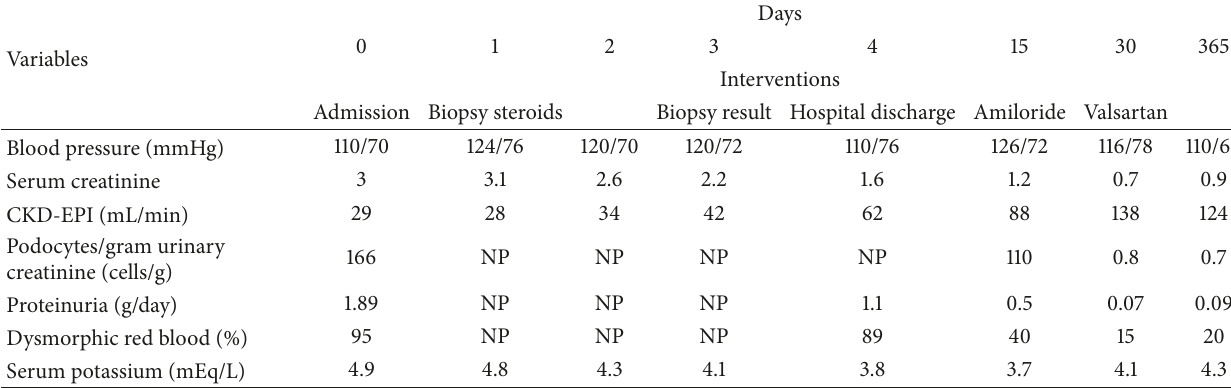
Table 1: Clinical, biochemical, and interventional